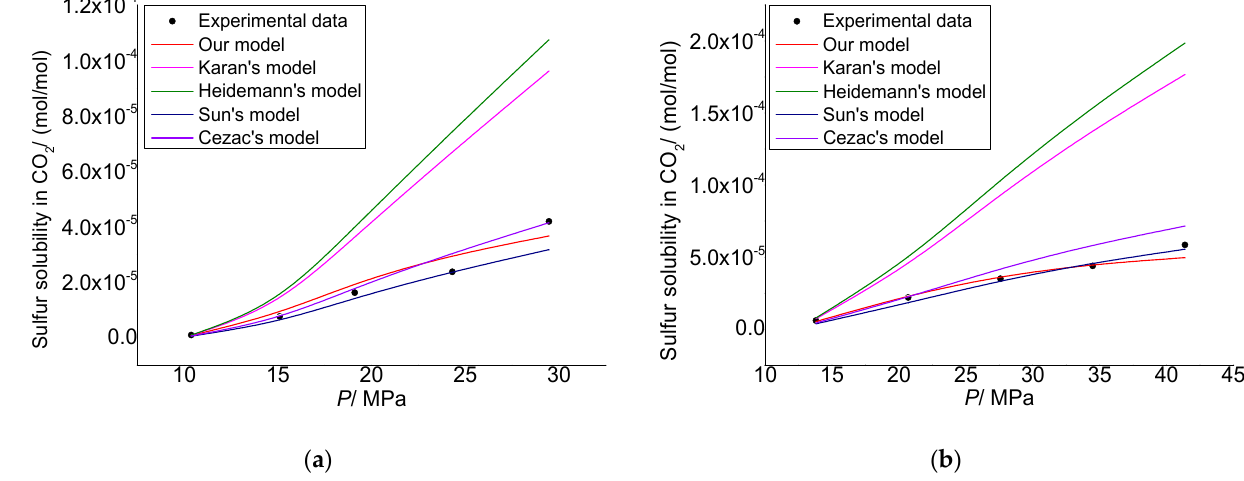
Figure 2. Comparison of sulfur’s solubility in CO 2 . ( a ) 333.15 K; ( b ) 338.71 K.